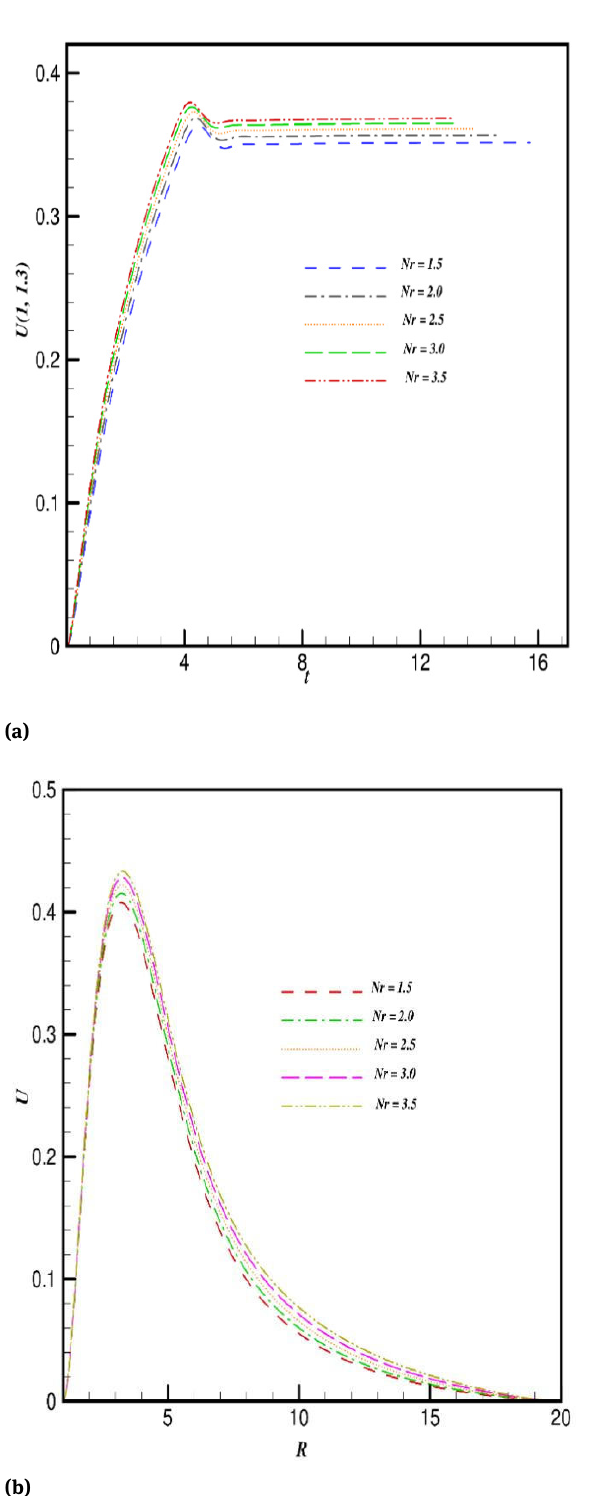
Figure 9: ( a ) Transient and ( b ) Steady state temperature profiles with fixed Sc = 0.6 , Pr = 0.7 , Bu = 1.0 , Kr = −0.2 , K 1 = 1.0 , M = 0.2 , Ec = 0.1